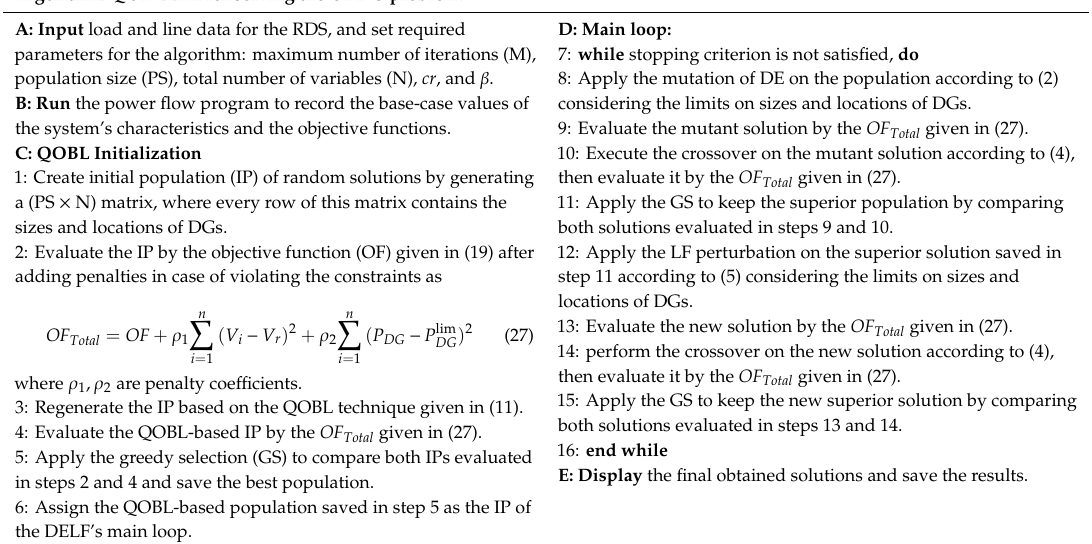
Algorithm: QODELFA for solving the OPDG